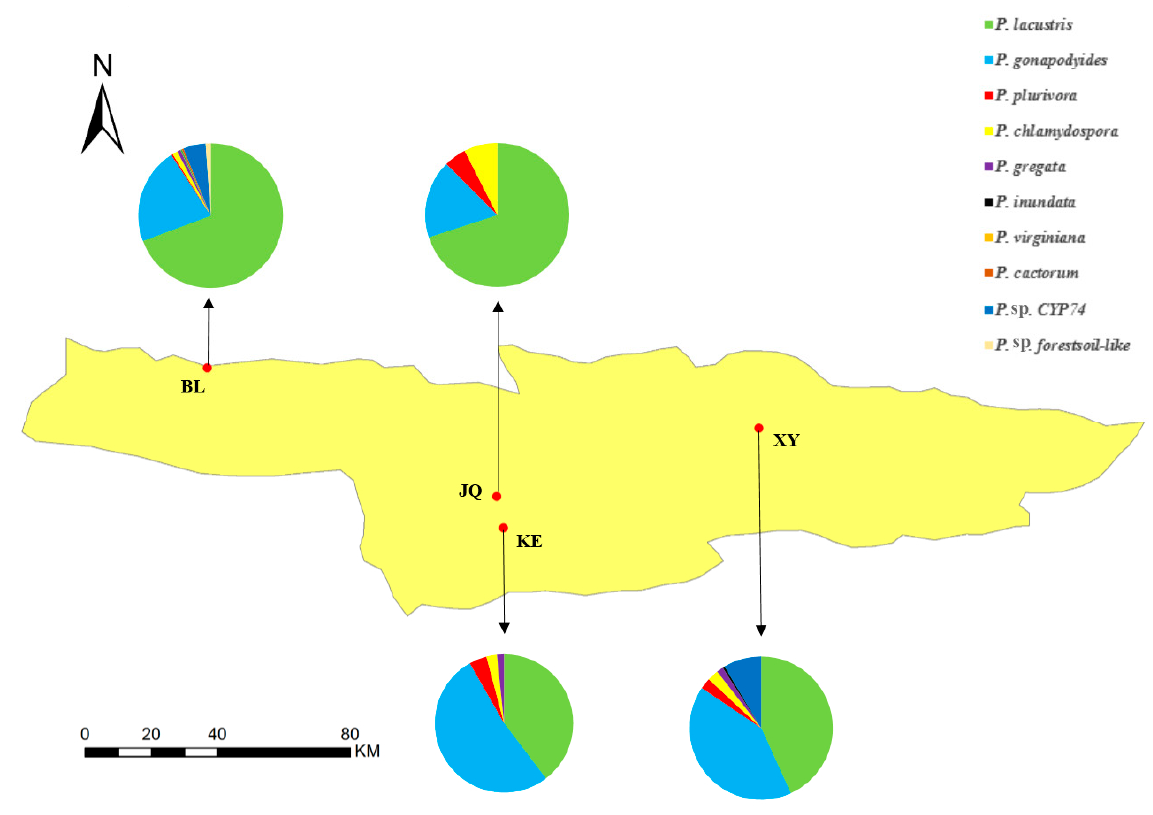
Figure 4. The Phytophthora species distribution at four plots.